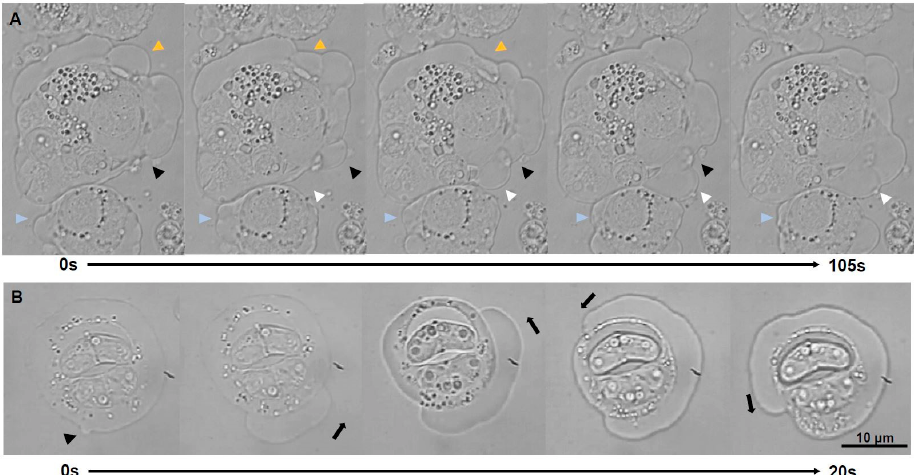
Figure 2. Light microscopy time-lapse series of blebbing stages of Ceratonova shasta genotype IIR from ascites of rainbow trout. ( A ) Polarized blebbing (total time elapsed 105 s, images every 21 s), head arrows point to surface positions of the stages where blebs are expanding and rectracting, with physical overlap of several blebs simultaneously. ( B ) Non-polarized blebbing or circus movement (total time elapsed 20 s, images every 5 s): a bleb expansion initiated and propagated along the circumference of the sporogonic stage (with 2 mature spores), fully circumnavigating the parasite.